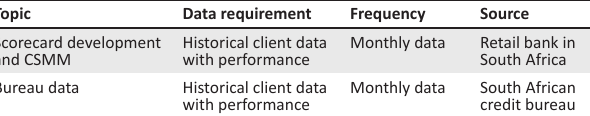
TABLE 3: Data used for research